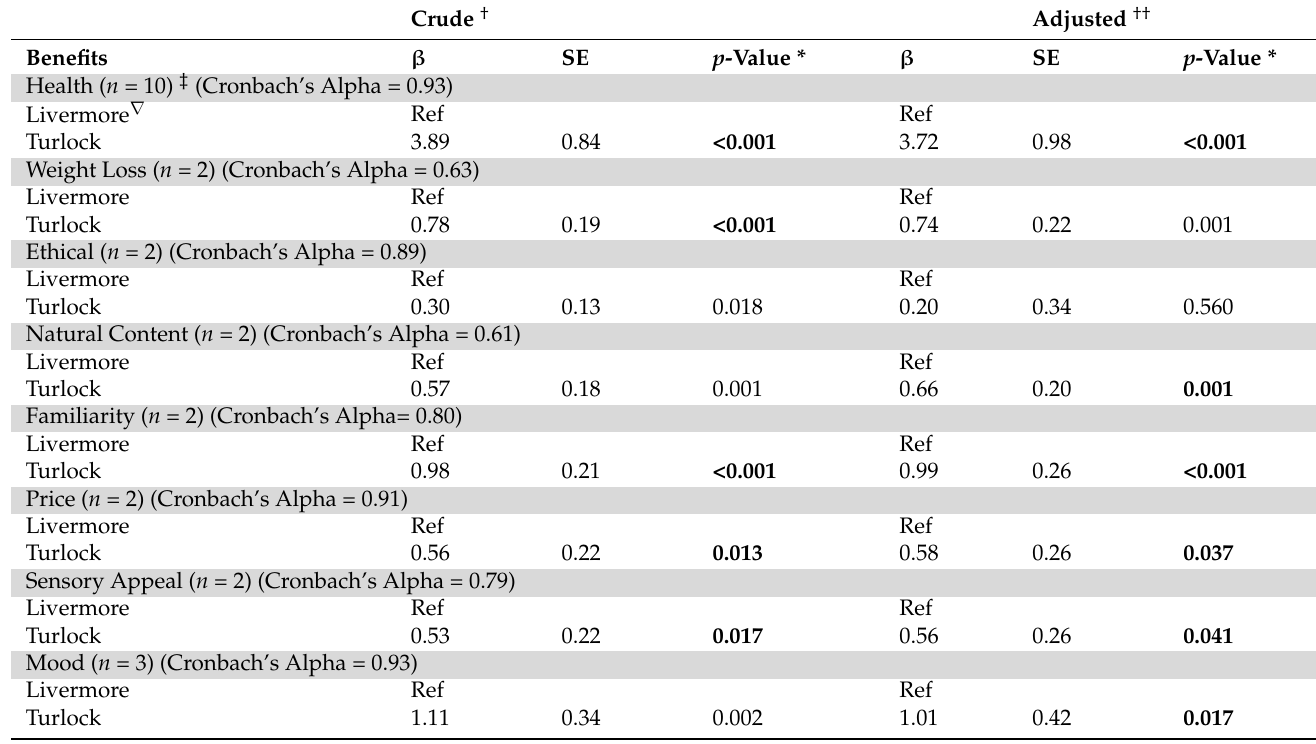
Table 4. Crude and adjusted linear analysis of perceived MD